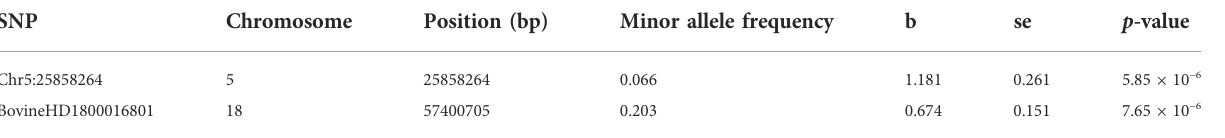
TABLE 1 SNPs signi fi cantly associated with BRD